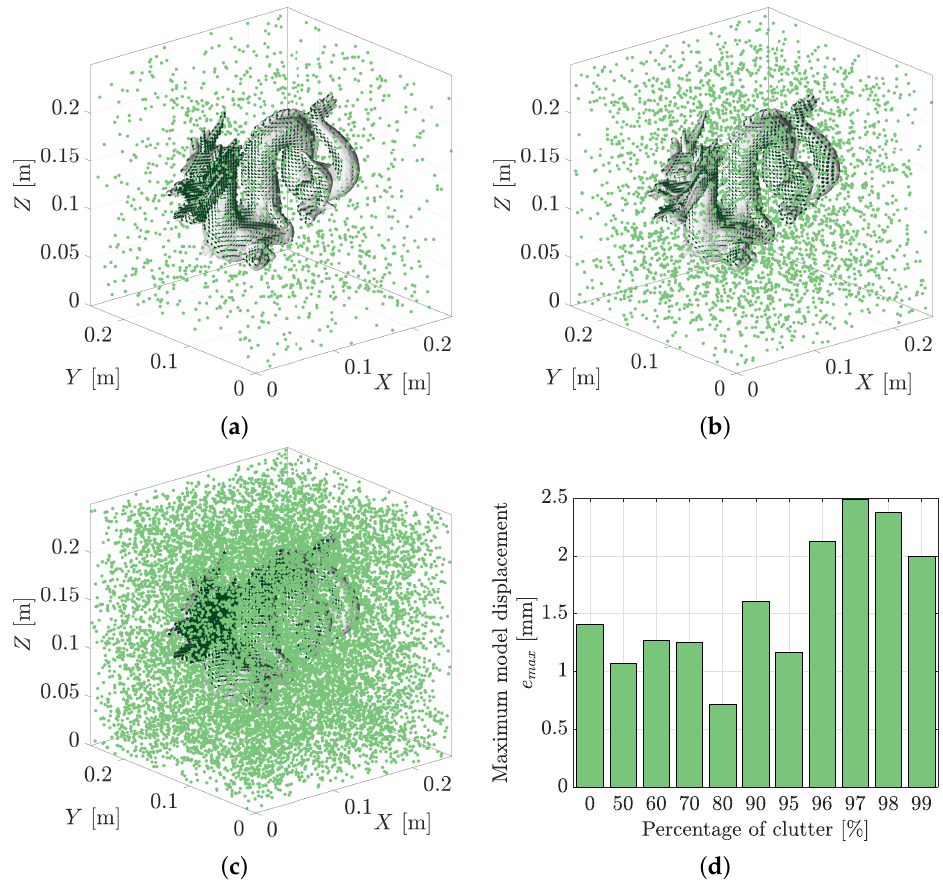
Figure 22. The maximum sum of evidence solution, H (cid:63) , is plotted against the ( a ) 50%, ( b ) 70%, and ( c ) 90% clutter measurement sets. Further testing was conducted on measurement sets consisting of up to 99% clutter (153,846 clutter : 1554 true). ( d ) The maximum geometric displacement of